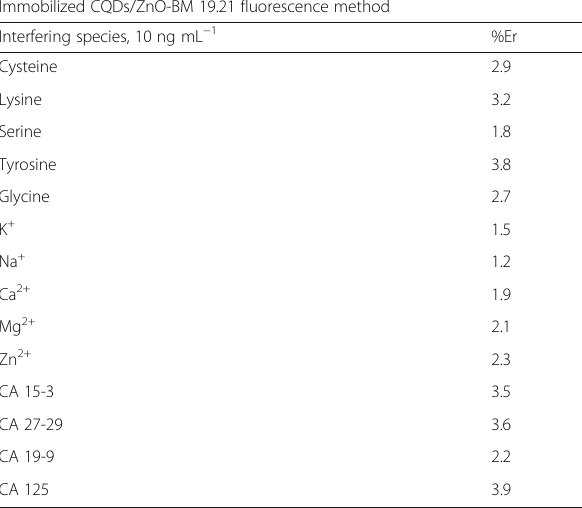
Table 3 Selectivity of the suggested immobilized CQDs/ZnO- BM 19.21 method towards the determination of CYFRA 21-1